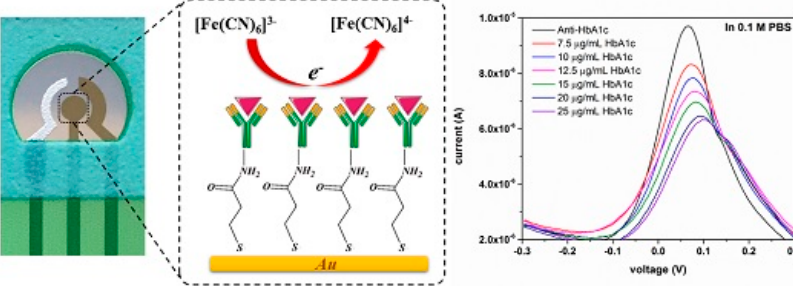
Figure 3. Response mechanism of label-free immunosensor for HbA1c sensor and its DPV in the presence of HbA1c. Reprinted from Liu et al. [41].